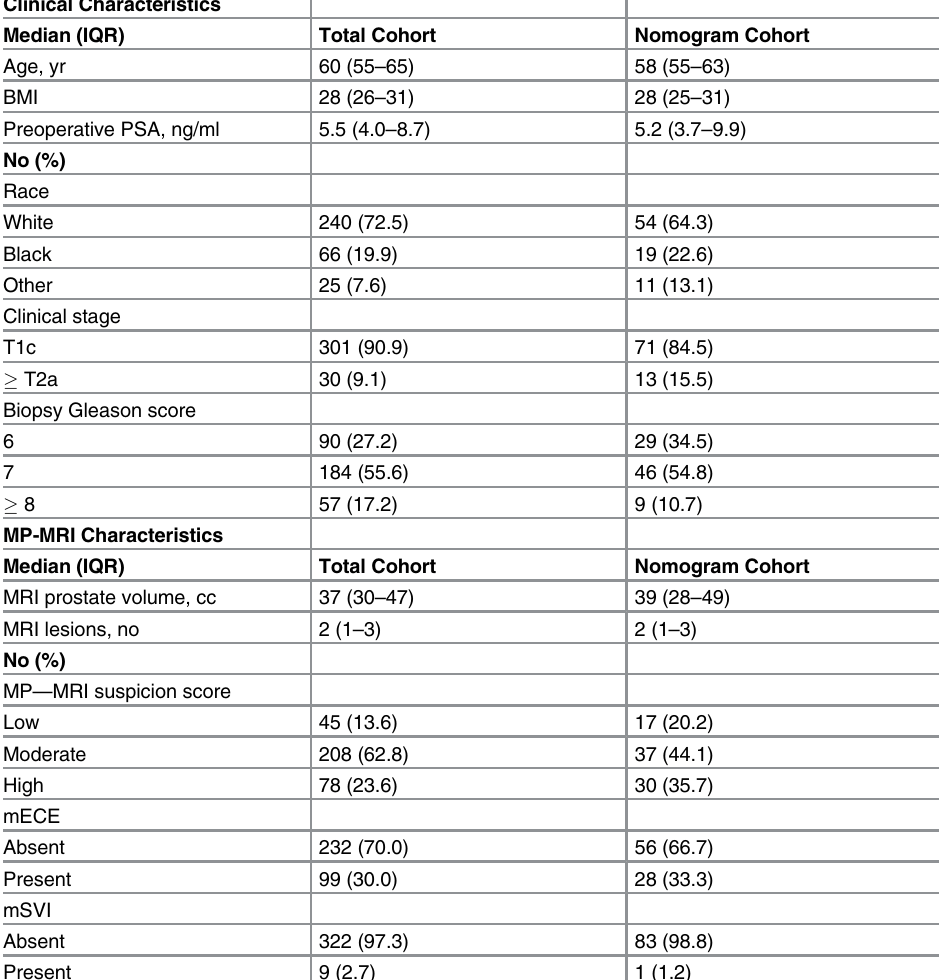
Table 1. Preoperative clinical and multiparametric magnetic resonance imaging characteristics of patients undergoing radical prostatectomy. Clinical